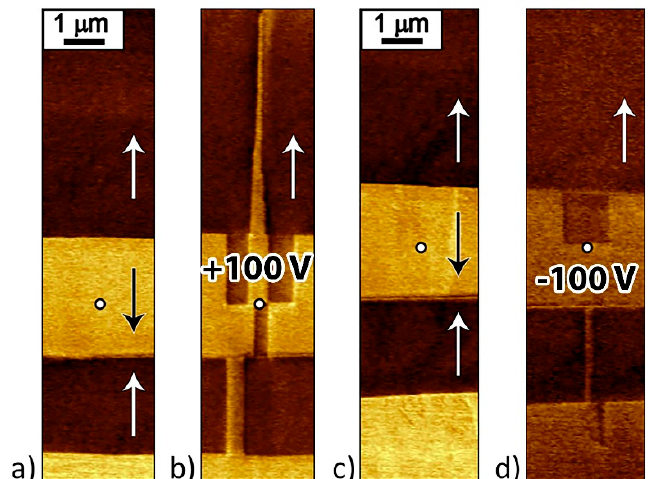
Figure 11. PFM images of written domains in the vicinity of as-grown domain wall without probe withdrawal. Domain structure ( a , c ) before and ( b , d ) after local polarization reversal by ( b ) positive and ( d ) negative voltage pulses. The arrows indicate the spontaneous polarization directions.